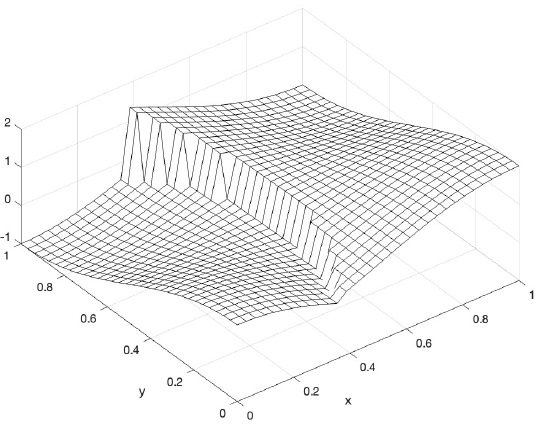
Figure 4. Plot of the low resolution data obtained from the function in (26).